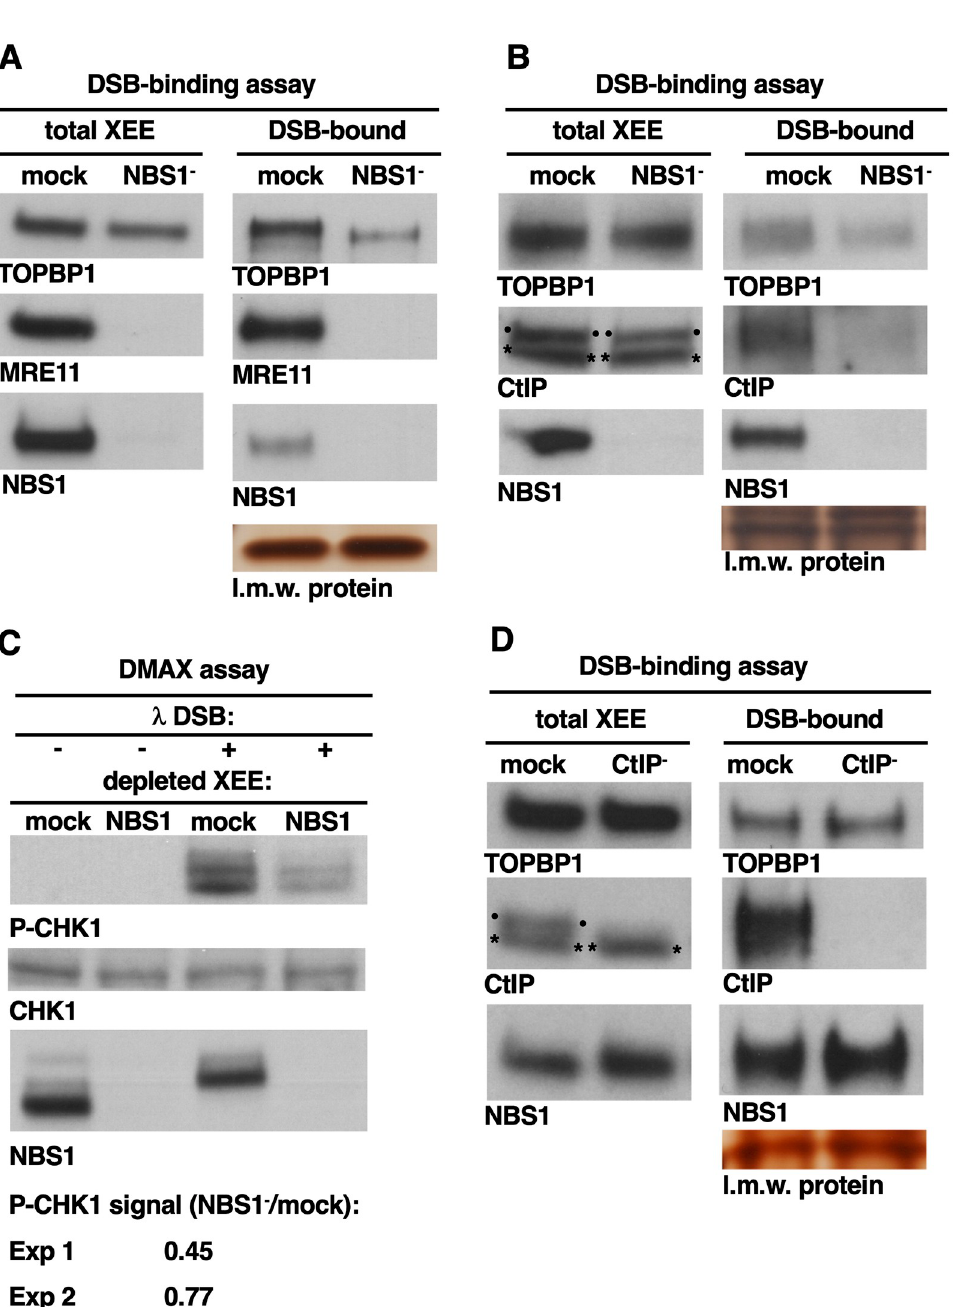
Fig 3. MRN is partially required for TOPBP1 recruitment to DSBs and ATR signaling. A. NBS1 antibodies were used to remove the MRN complex from XEE via immunodepletion. A mock-depleted sample was also prepared. The depleted extracts were then probed for the indicated proteins (panels “total XEE”). Note that NBS1 depletion results in the removal of all detectable NBS1, as well as MRE11, showing that the MRN complex has been removed. Note also that TOPBP1 is not co-depleted by the NBS1 antibody. The depleted extracts were then used for a DSB binding assay, and panels “DSB- bound” shows the occupancy of the indicated proteins on the DSB beads. The experiment shown is representative of two independently performed biological replicates. B. Same as (A) except CtIP occupancy was examined in this experiment. The experiment shown is representative of two independently performed biological replicates. C. NBS1 antibodies were used to remove the MRN complex from XEE via immunodepletion. A mock-depleted sample was also prepared. The depleted extracts were then used for a DMAX assay to asses ATR’s ability to phosphorylate its key substrate, CHK1. “ λ DSBs”refers to phage lambda DNA that was digested with EcoRI and represents the source of DSBs for this experiment. DSBs were optionally added to the depleted extracts, and after incubation samples were pulled and probed for P-CHK1,